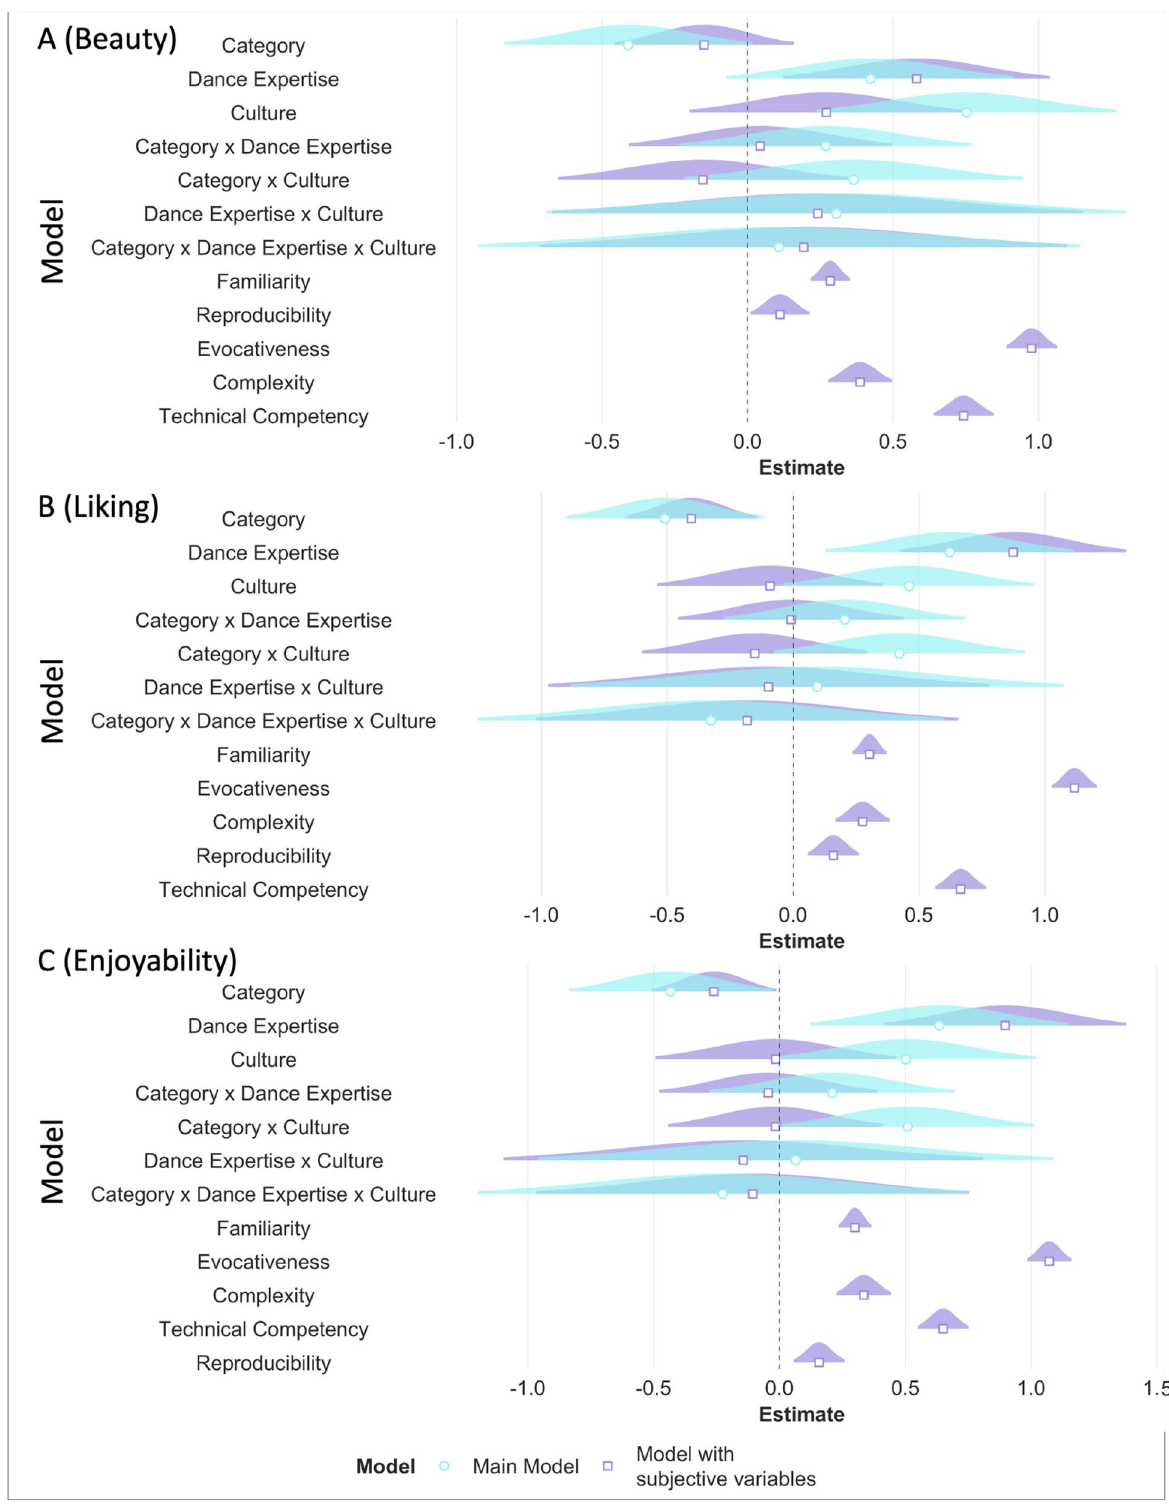
Figure 11. RQ1: The effect of category, expertise, and culture. For the outcome variables of beauty ( A ), liking ( B ), and enjoyability ( C ) beta estimates for the main model (in aqua blue) and the model with subjective variables (in purple) are plotted for each predictor variable (fixed effect) along with their corresponding uncertainties (95% confidence interval width for a normal distribution for each estimate). Distributions are rescaled to match the height of each